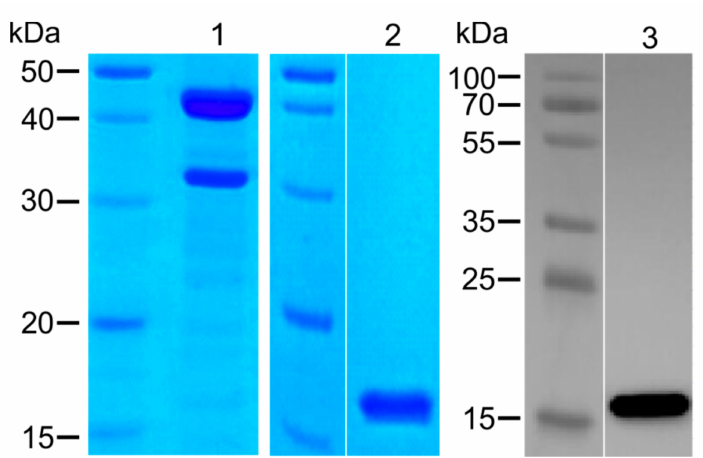
Figure 1. SDS-PAGE and Western blot analysis of α -synuclein. GST-His 6 - α -synuclein